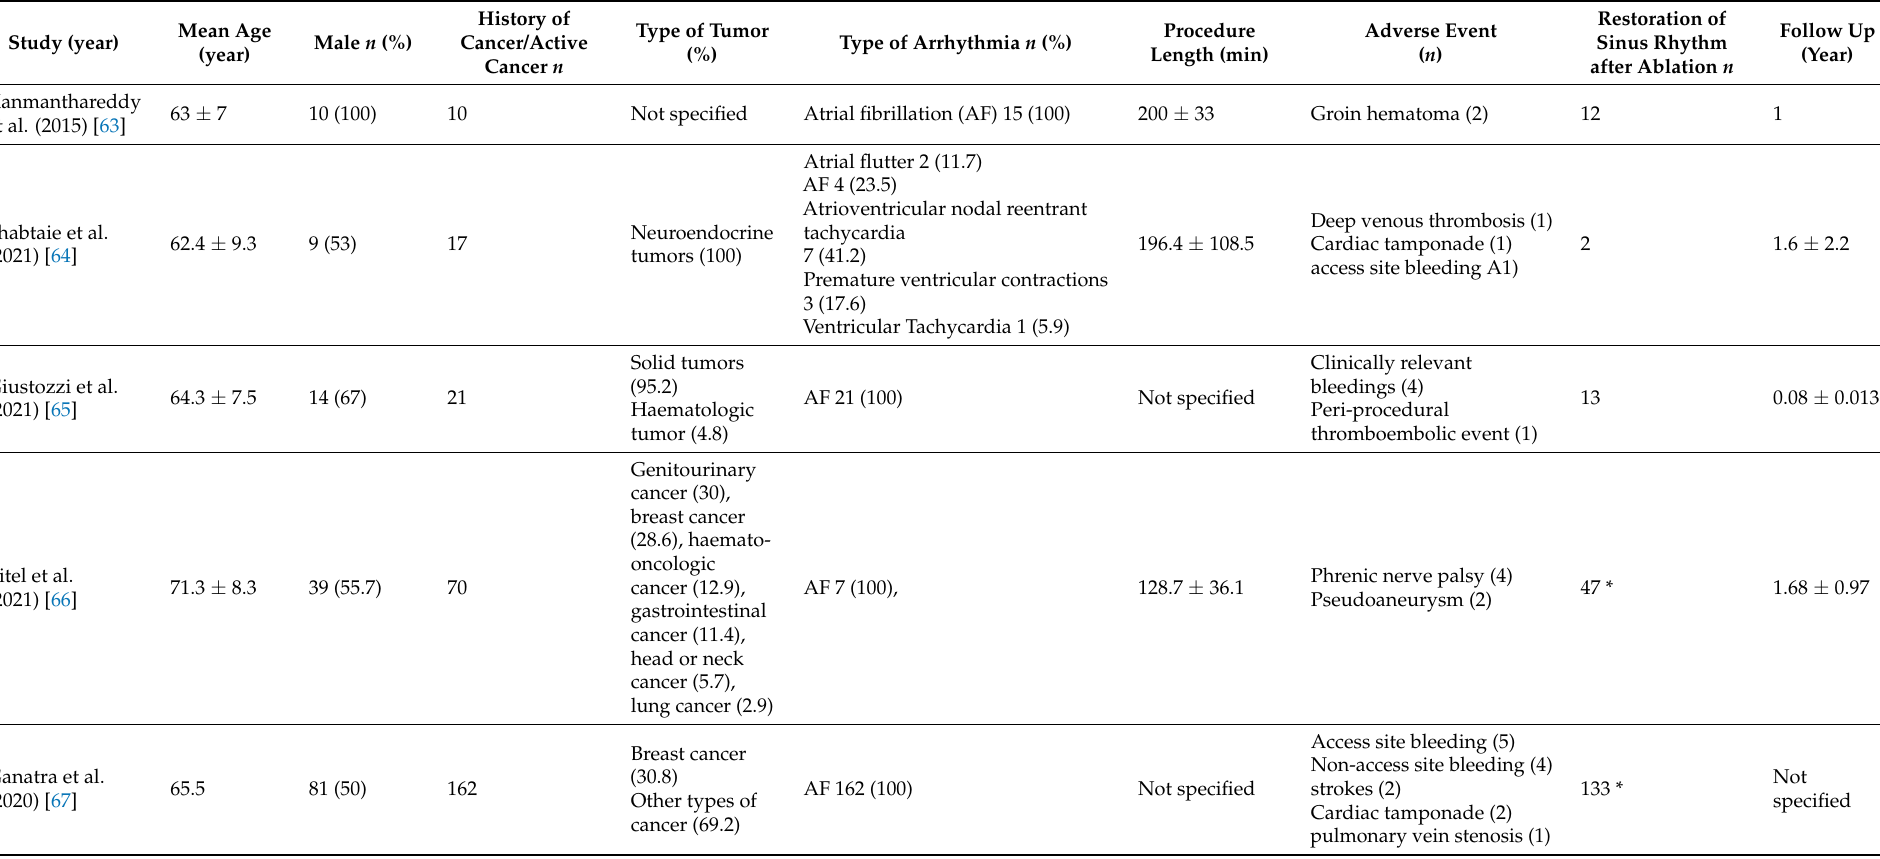
Table 2. PVI in cancer